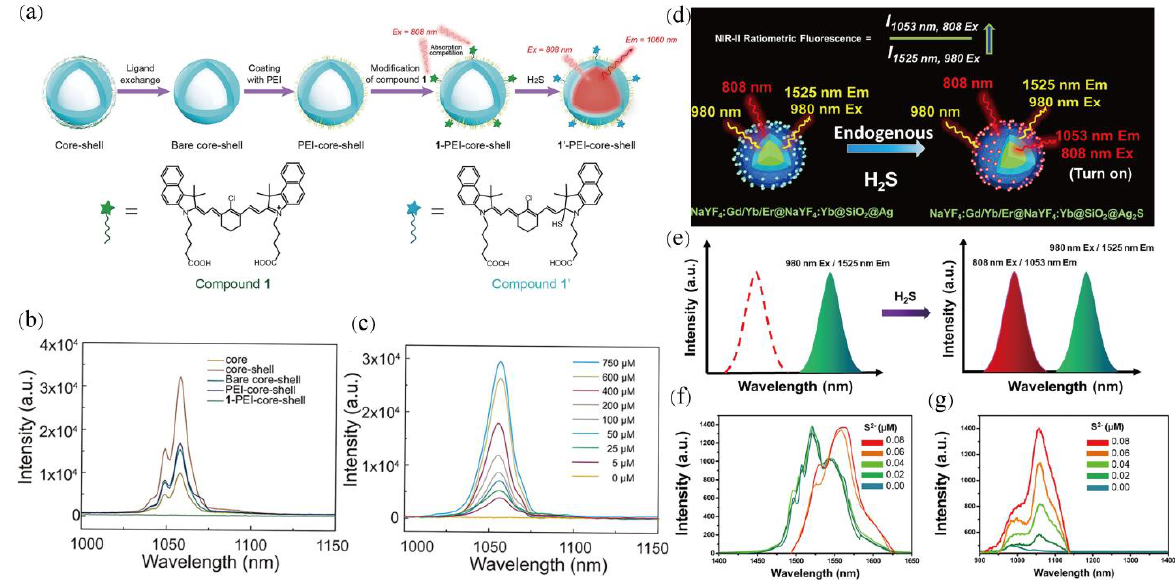
Figure 10. ( a ) Schematic illustration for the synthesis route of 1−PEI−LnNCs. ( b ) NIR−II lumines- cence spectra of 1−PEI−LnNCs. ( c ) NIR-II spectra of 1-PEI-LnNCs upon gradual addition of Na 2 S. Adapted, with permission, from Ref. [100]. Copyright 2021, American Chemical Society. ( d ) Ra- tional design of activatable orthogonal NIR−II emitting LnNCs@ SiO 2 @Ag nanoprobes for H 2 S. ( e ) Activatable ratiometric fluorescence probe with H 2 S responsive turn- on orthogonal NIR−II emis- sion. ( f , g ) NIR−II spectra by adding different concentrations of Na 2 S under 980 nm and 808 nm, respectively. Adapted, with permission, from Ref. [101]. Copyright 2021, American Chemical Soci-